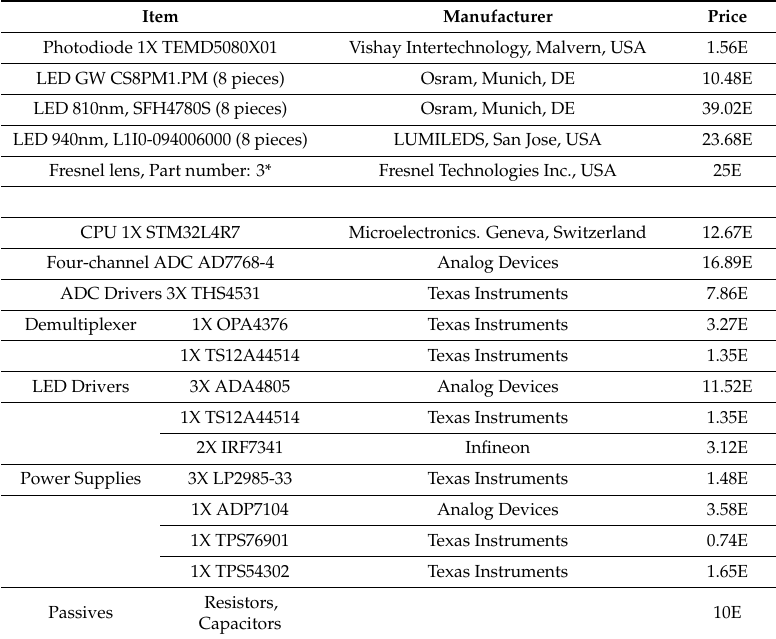
Table A1. Cost break-down of the multispectral sensor and recorder